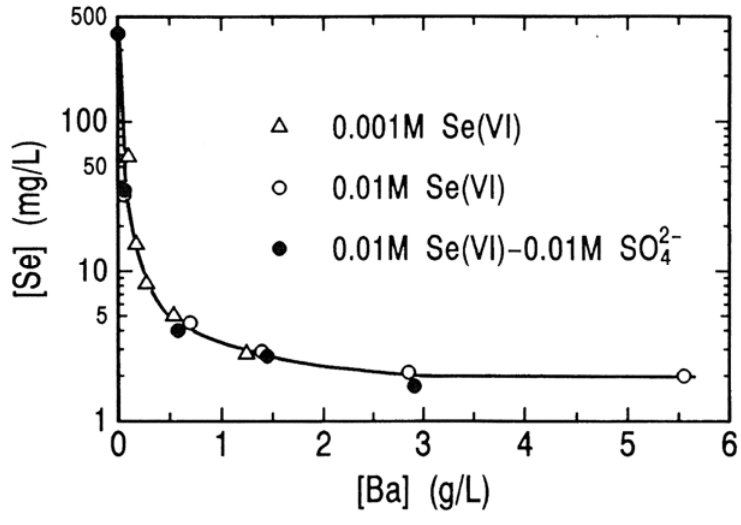
Figure 13. A plot of the residual selenium(VI) concentration versus the residual barium concentration after precipitation of BaSO pH = 6; 25 °C; 24